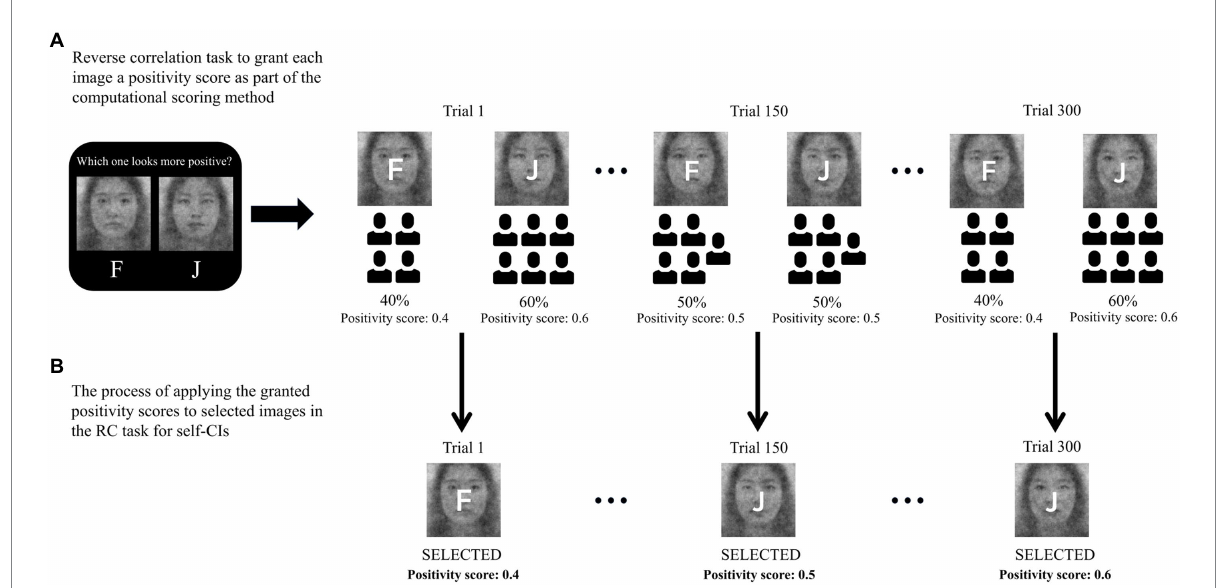
FIGURE 3 Procedure to evaluate positivity of the selected images in the reverse correlation (RC) task for self-CIs, which we named the computational scoring method. (A) RC task was performed to select the more positive image out of two to grant each image a positivity score as part of the computational scoring method. (B) The granted positivity score in (A) was applied to the selected images in the RC task for self-CIs, in which participants chose one that bore stronger